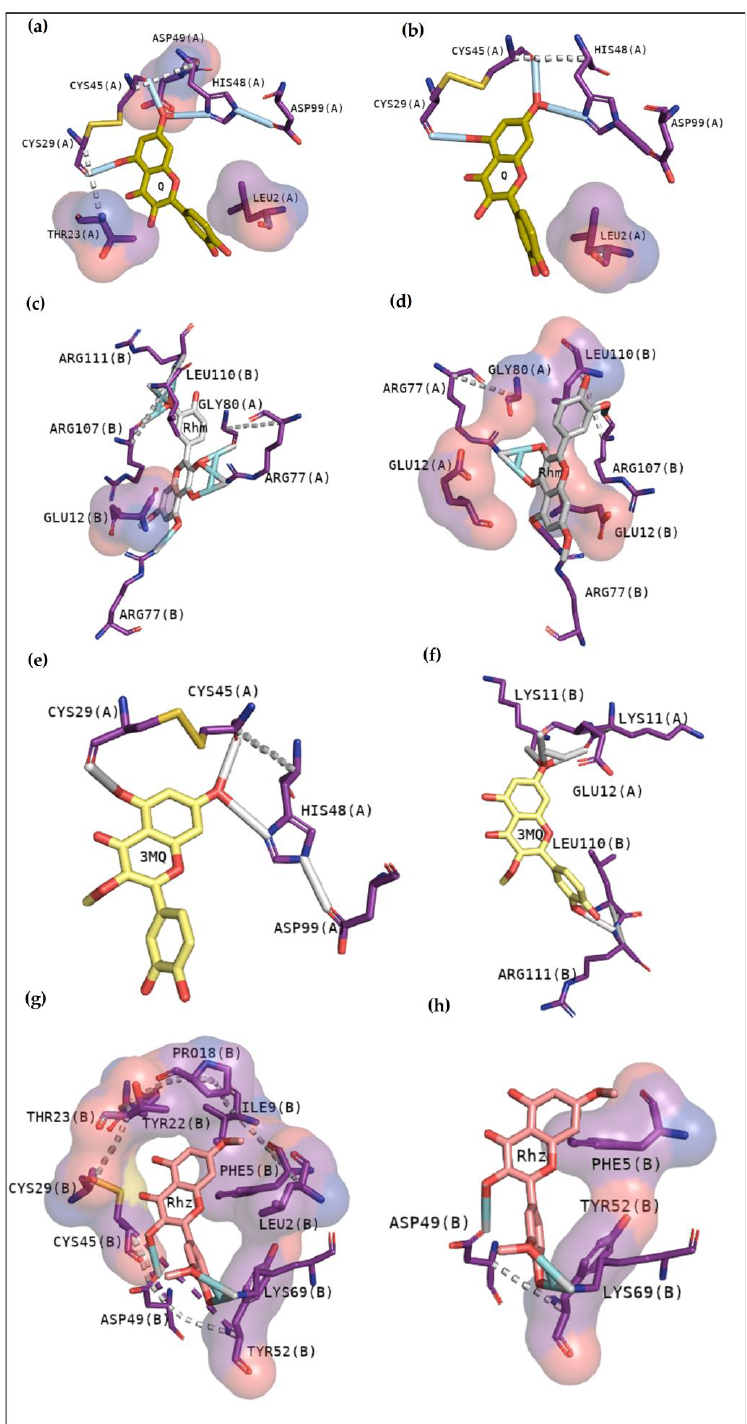
Figure 7. Docking results of BthTX-II with quercetin derivatives. Q reveals to anchor with the active site in the first ( a ) and also in the second cluster ( b ), while Rhm fits in the interface between the chains, emphasizing Gly80, Leu110 and Arg 111 in the first ( c ) and second clusters ( d ). First, 3MQ reveals hydrogen bond with His48 and Cys45 ( e ), and in the second cluster, it was observed contacts with N-terminal and C-terminal region with both chains ( f ). Rhz first shows to anchor with active site and the N-terminal region with mostly hydrophobic contacts ( g ), and in the last cluster, similar residues are shown ( h